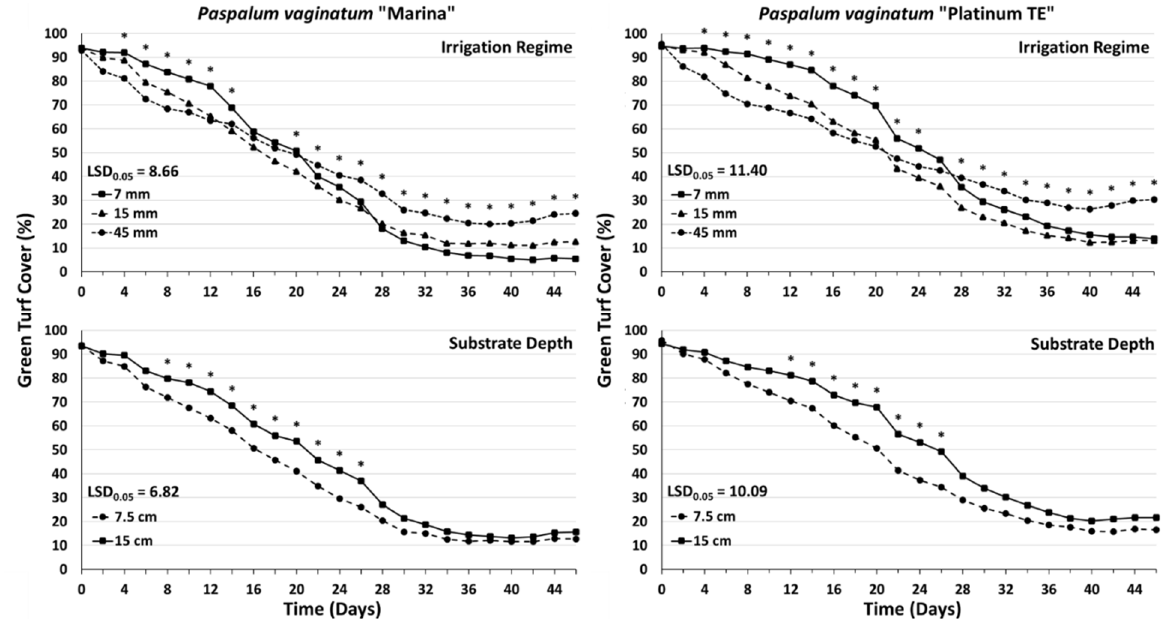
Figure 5. Green turf cover (%) of the two Paspalum vaginatum varieties “Marina” and “Platinum TE”, as affected by seawater irrigation regimes (7 mm, 15 mm, or 45 mm) and green roof substrate depth (7.5 cm or 15 cm) during the salinity stress period (29 July–13 September 2016). Values are the mean of 4 replications. Asterisks (*) indicate significant differences in-between treatment means on a single sampling date, according to Fisher’s least significant difference (LSD) at p < 0.05 following the repeated measures model.